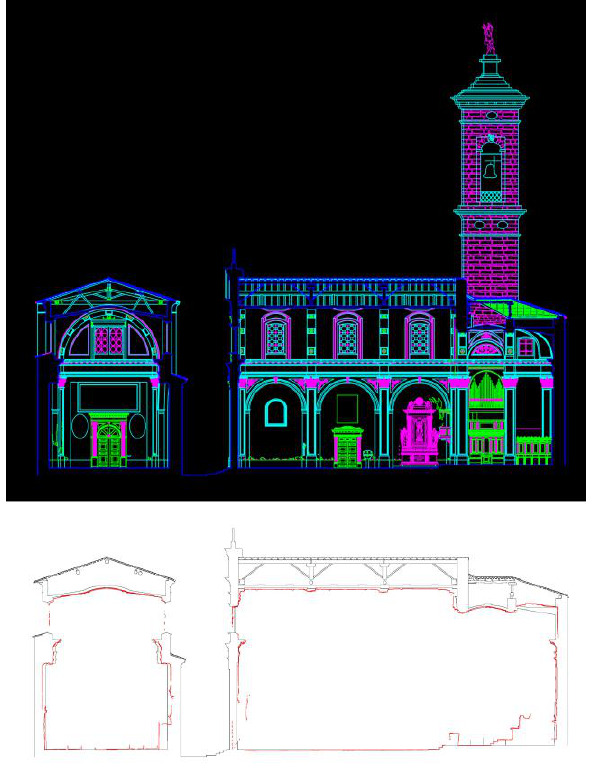
Figure 15. Differences between the survey and the point clouds